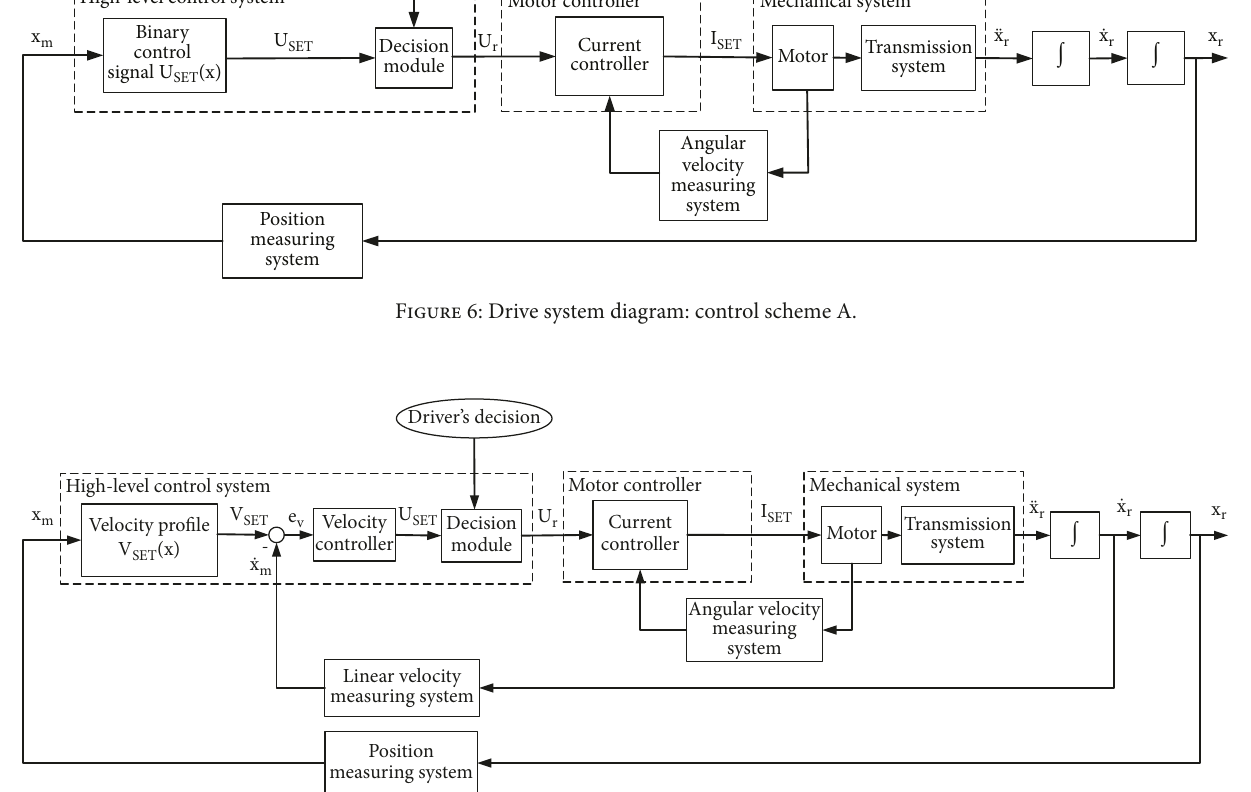
Figure 7: Drive system diagram: control scheme